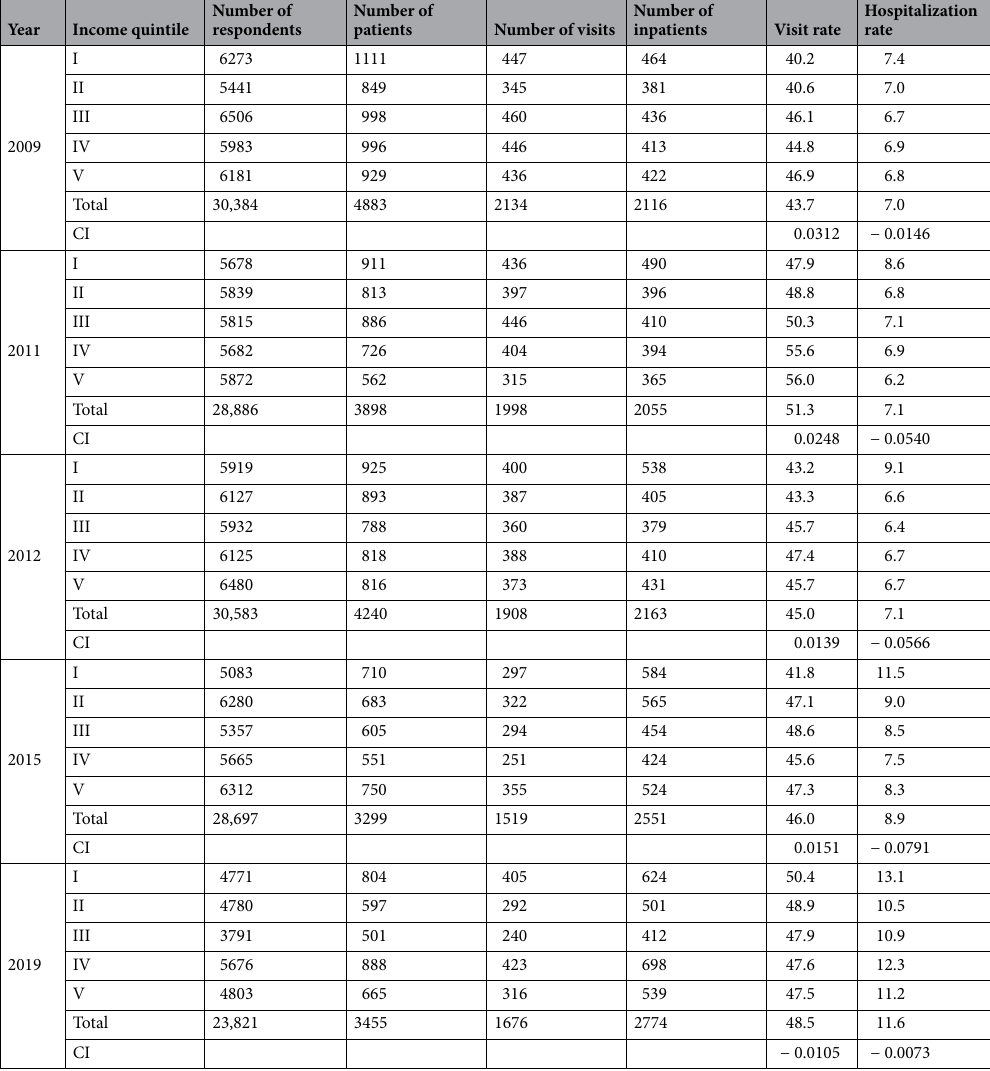
Table 1. Dynamic changes in the equity of health service utilization in different income groups from 2009 to